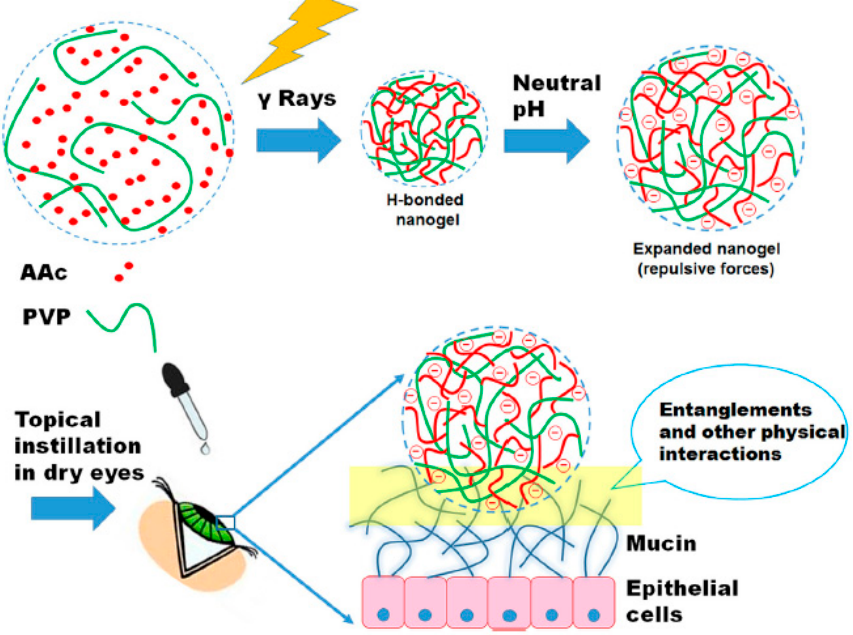
Figure 8. An overview of the preparation mechanism of PVP/PAAc nanogel [49].